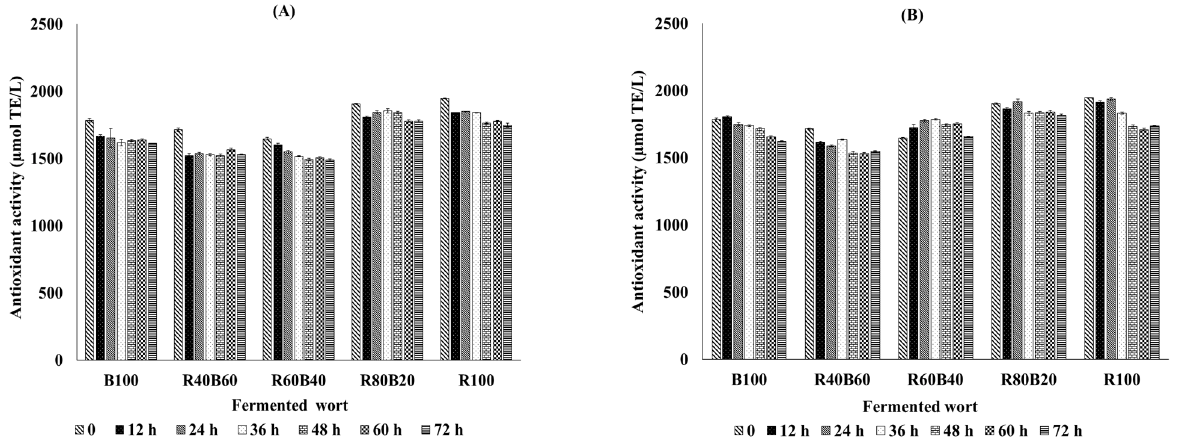
Figure 5. Changes in antioxidant activity via DPPH in fermented wort (B100, R40B60, R60B40, R80B20, and R100) by the two yeast strains BRY 97 ( S. cerevisiae ), POF − ( A ); and Belle Saison ( S. cerevisiae var. diastaticus ), POF + ( B ) .